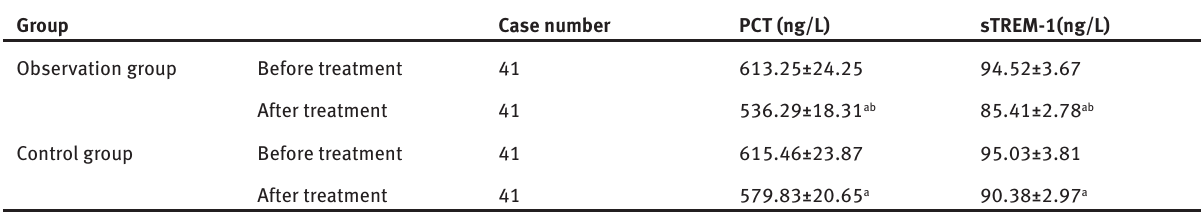
Table 4: Comparison of serum PCT and sTREM-1 between two groups before and after treatment ( ±s)